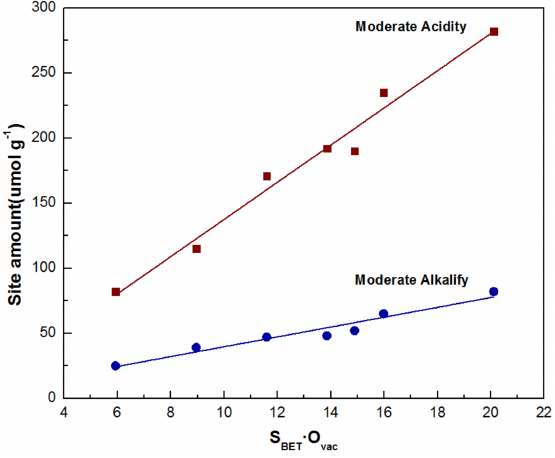
Figure 3. Liner relationship of moderate acidic/alkaline sites contrast specific surface area and surface oxygen